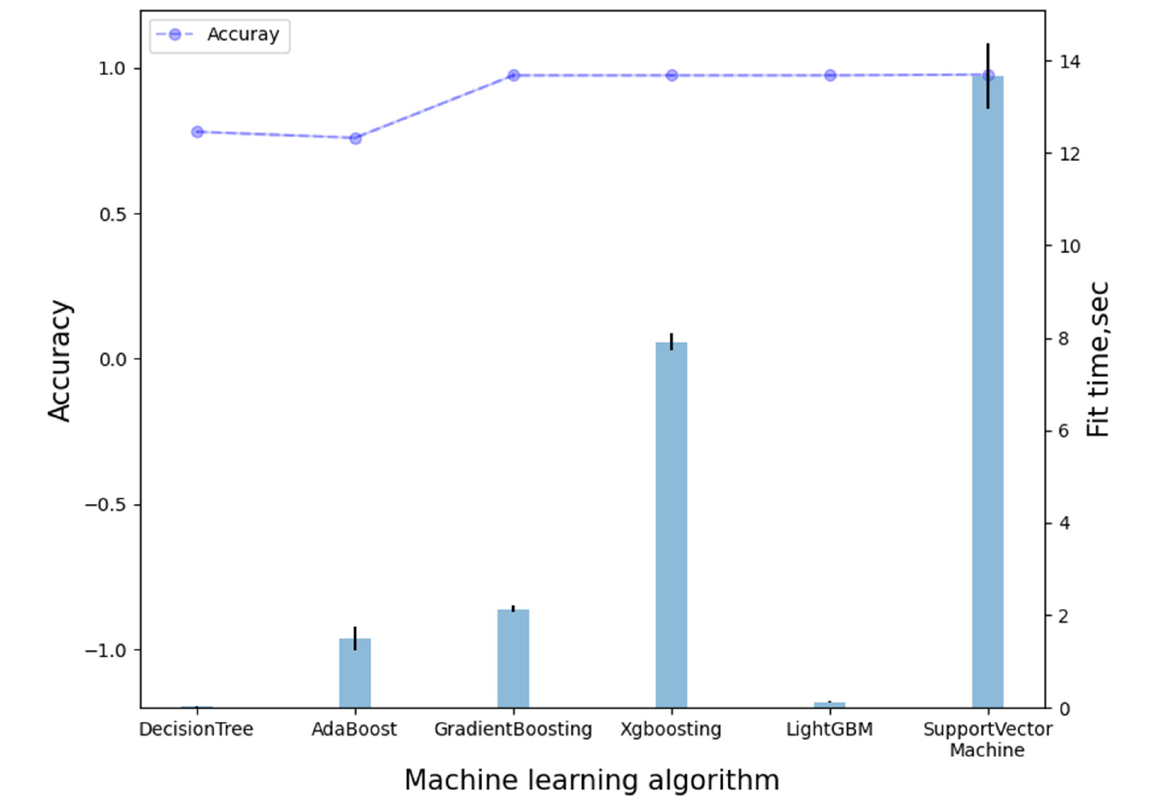
Figure 8. Summary of accuracy and fit times for cross-validation.